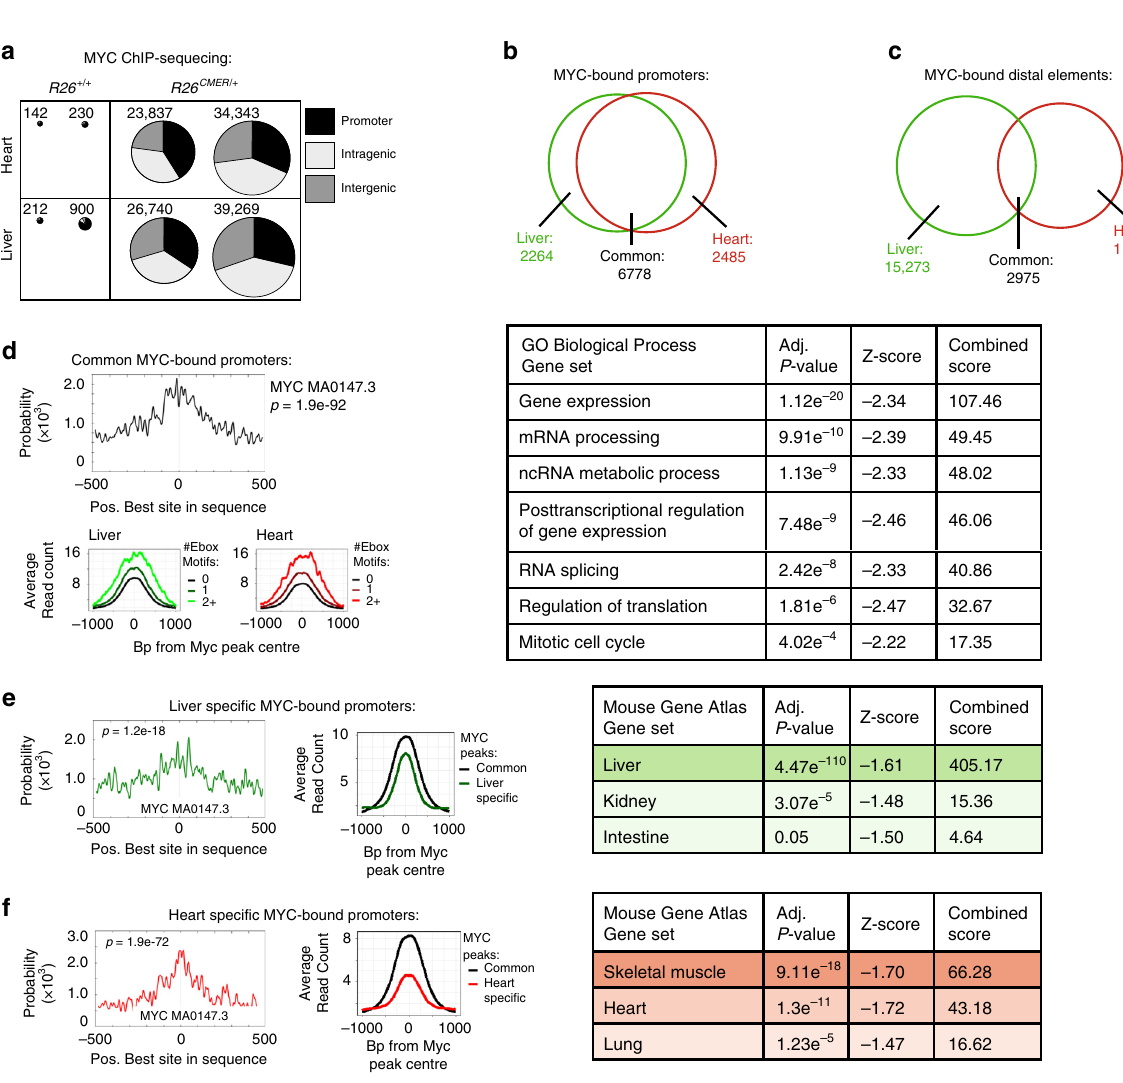
(Supplementary Fig. 5c, e). Conversely, ectopic overexpression of Cyclin T1 in adult R26 CMER/ + cardiomyocytes in vitro ef fi ciently abrogated their normal refractoriness to Myc and permitted ef fi - cient expression of Myc target genes previously shown to be Myc unresponsive in adult heart ( Bzw2 , Pinx1 , Polr3d , St6 and Cdc25a ; Fig. 5d, e, Supplementary Fig. 5f, g). Together, these data support